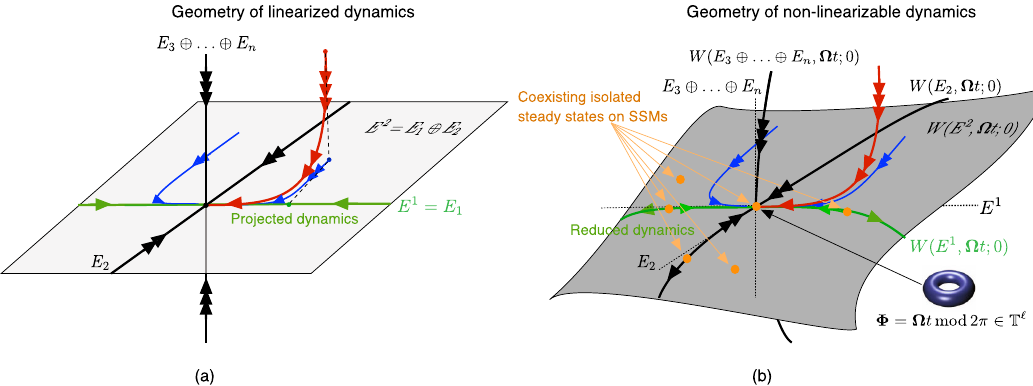
Fig. 2 Linear vs. nonlinear model reduction. a Reduction of linear dynamics via Galerkin projection. The slowest spectral subspace, E 1 = E 1 (green), and the modal subspace, E 2 (black), span together the second slowest spectral subspace, E 2 = E 1 ⊕ E 2 . The full dynamics (red curve) can be projected onto E 1 to yield a reduced slow model without transients. Projection of the full dynamics onto E 2 (blue curve) yields a reduced model that also captures the slowest decaying transient. Further, faster-decaying transients can be captured by projections onto slow spectral subspaces, E k , with k > 1. b Reduction of nonlinearizable dynamics via restriction to spectral submanifolds (SSMs) in the ϵ = 0 limit of nonlinear, non-autonomous systems forced with ℓ frequencies. An SSM, W ( E , Ω t ; 0), is the unique, smoothest, nonlinear continuation of a nonresonant spectral subspace E . Speci fi cally, the slowest SSM, W ( E k , Ω t ; 0) (green), is the unique, smoothest, nonlinear continuation of the slowest spectral subspace, E k . Nonlinearizability of the full dynamics follows if isolated stationary states coexist on at least one of the SSMs. The time-quasiperiodic SSMs for ϵ > 0, denoted W ( E , Ω t ; ϵ ), are not shown here but they are O ð ϵ Þ C r -close to the structures shown, as discussed by 29